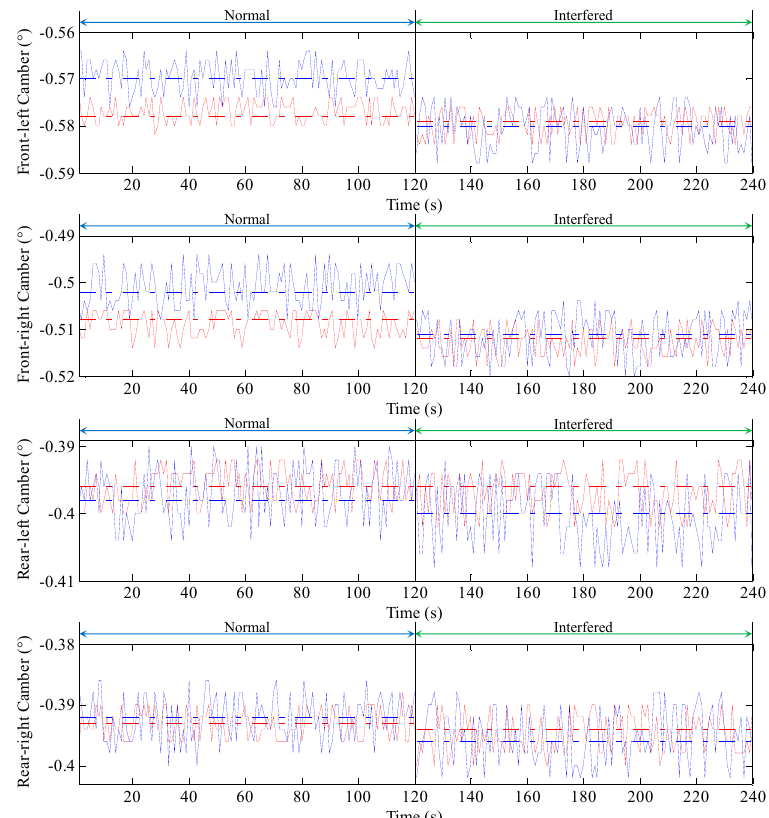
Figure 19. Camber as a function of time stamp for each wheel position. Solid curves (dashed lines) in red and blue denote function values (medians) for the proposed and built-in techniques, respectively. Regarding normal and interfered periods.